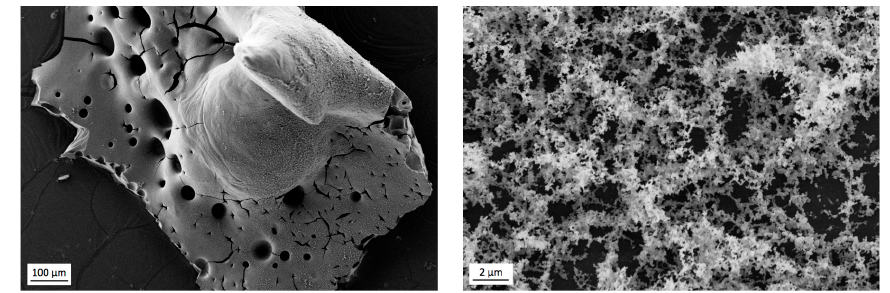
Figure 11. SEM images of the char morphology of cone calorimeter samples from neat novolac, 2.3 vol.% SiO 2 , 2 wt.% phosphorous + 2.7 vol.% SiO 2 and 3 wt.% phosphorous + 2.8 vol.% SiO 2 ) modified resin, with lower (left) and higher magnification (right).